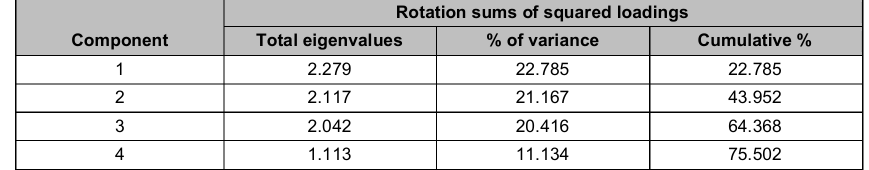
Total variance explained: perceptions towards informal venture capital Rotation sums of squared Component